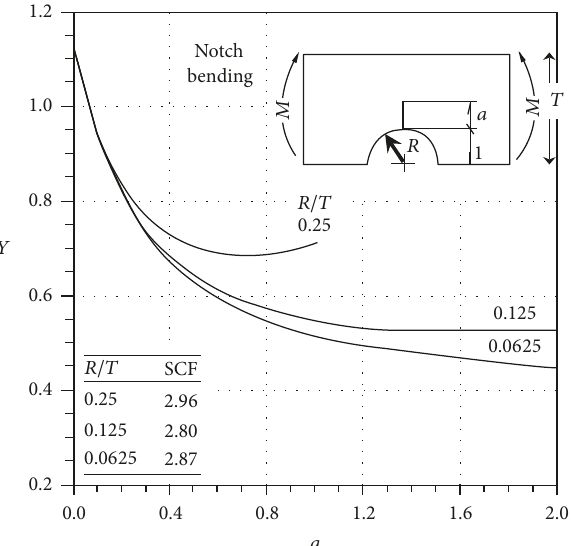
Figure 14: Weight function 𝑌 factors for an edge crack at a sem- icircular notch in an infinite plate subjected to in plane bending